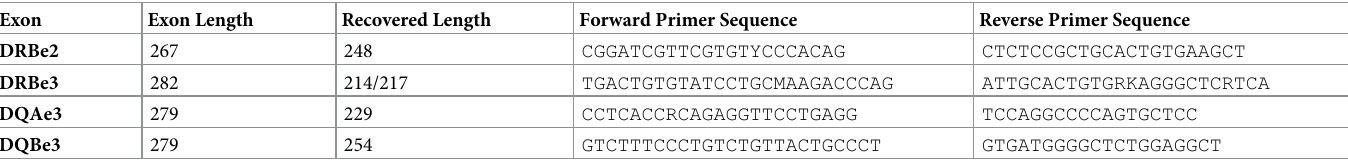
Table 1. Exon sequence and primer